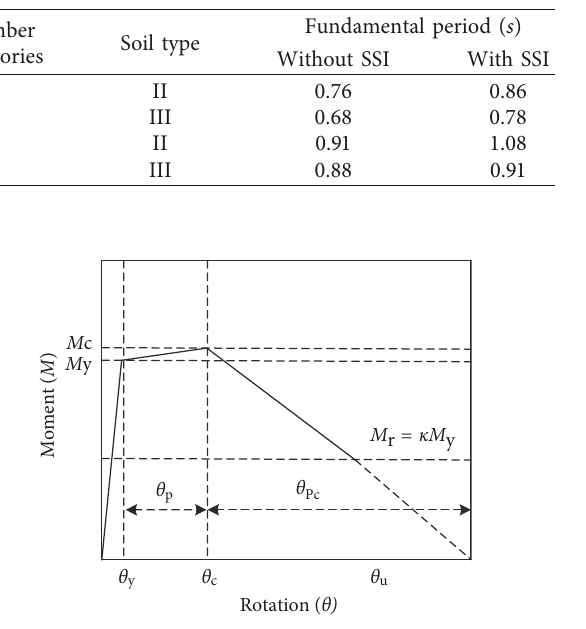
Table 4: The fundamental period of the designed frames.